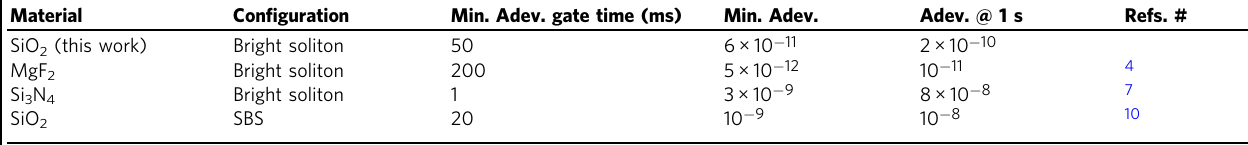
Performance of an on-chip silica bright soliton microcomb (this work), a Crystalline bright soliton microcomb 4,35 , a Si 3 N 4 bright soliton microcomb 7 , a Si 3 N 4 dark soliton microcomb 8 , a SiO 2 Brillouin laser 10 , a Si 3 N 4 Brillouin laser 13 , and a hybrid electric-Brillouin oscillator 52